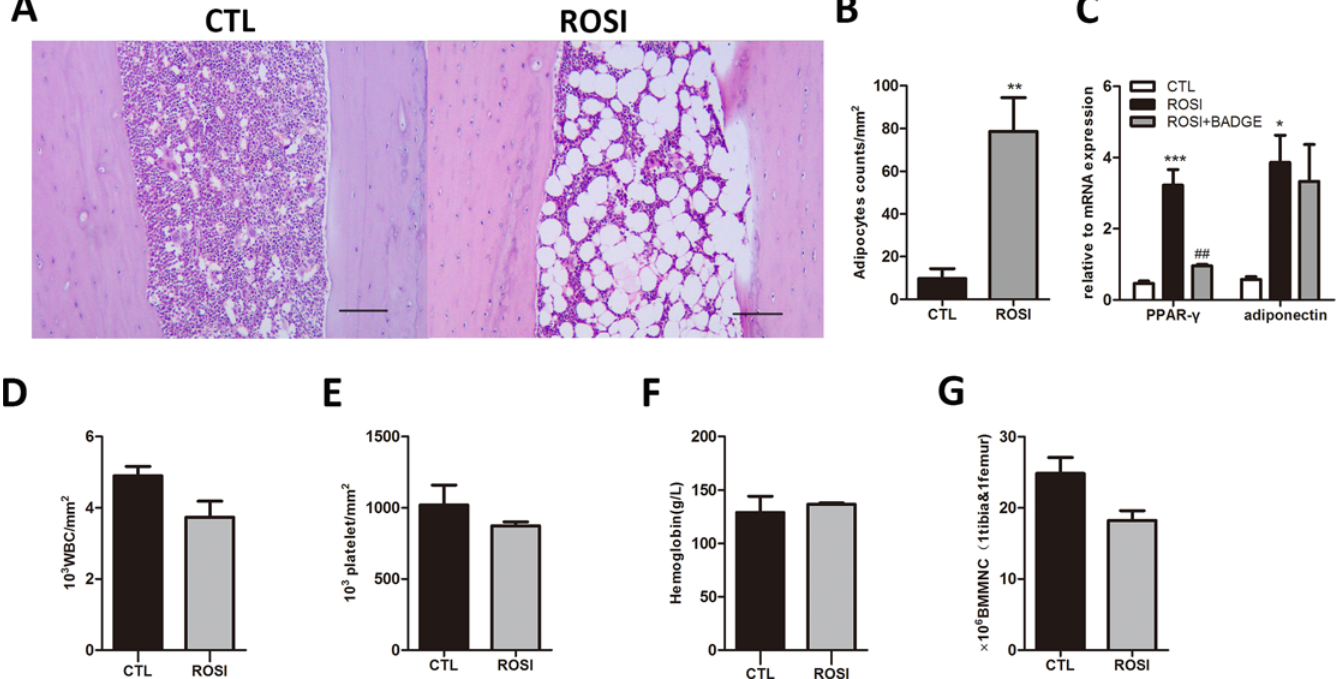
Fig 1. Normal homeostatic hematopoiesis in rosiglitazone-treated mice. (A) Adipocytes in tibia BM sections from rosiglitazone-treated and control mice (HE staining, scale bar 200 μ m).(B) Adipocyte counts per mm 2 in tibia BM sections from both groups of mice. (C) Expression of PPAR γ 2 and adiponectin in BMMNCs from the two groups of mice. (D-F) No significant differences in peripheral blood(PB) counts were observed in rosiglitazone-treated mice compared to the control mice. (G) A decreased bone marrow mononuclear cell(BMMNC) count was observed in rosiglitazone-treated mice compared to control mice, but this difference was not statistically significant( P = 0.066). The data are presented as the means ± SD from three independent